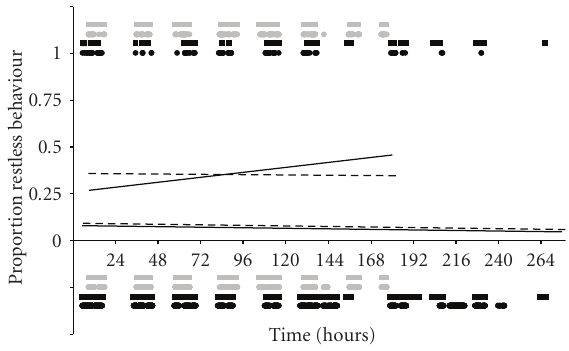
Figure 4: Observed positions and predicted use of lower half of the enclosure over time (hours after the start of the experiment) among treatment and control reindeer from two sources: domestic tame (Finnmark) and domestic wild (V˚ag˚a). A higher value illustrates more frequent use of the lower part of the enclosure. Lines represent the estimates from zone 1 (the model intercept). Dashed and solid lines represent treatment and control animals, respectively. The two lower lines represent domestic tame animals, while the two upper represent domestic wild. The distributions of observations of animals being located in the lower and upper part of the enclosure are shown as symbols at the top and at the bottom, respectively. Black and grey symbols represent domestic tame and domestic wild, respectively. Circles and squares represent control and treatment animals, respectively.